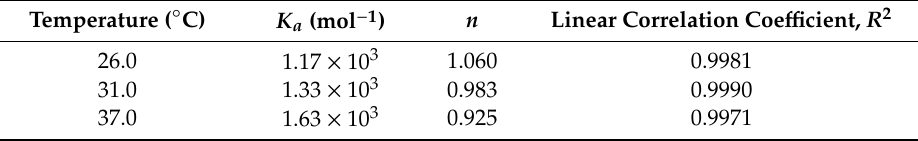
Table 2. Binding constants ( K a ) and binding sites ( n ) of physcion and Semen Cassiae proteins at 26.0, 31.0 and 37.0 ◦